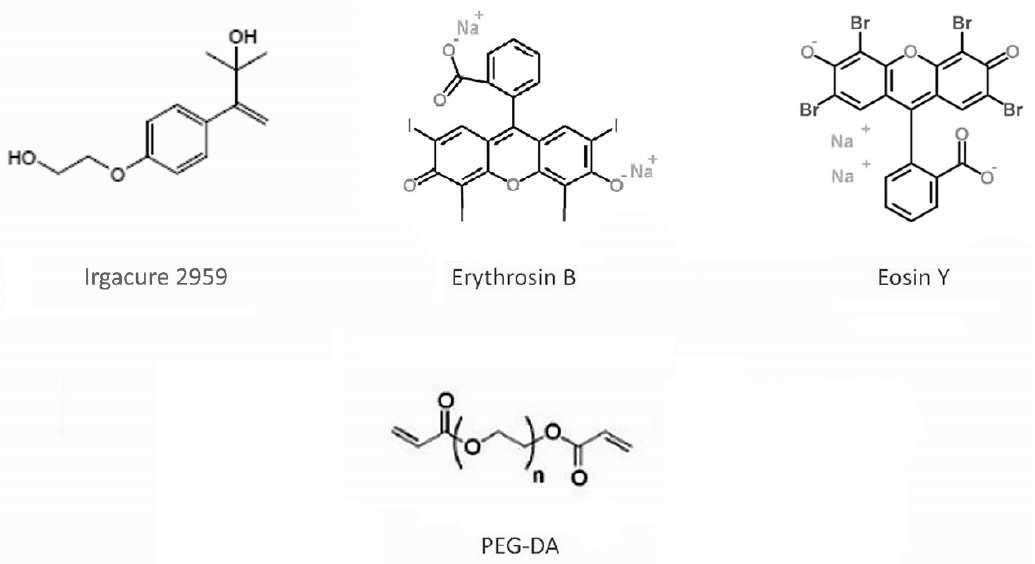
Figure 3. Irgacure 2959, Erythrosin B and Eosin Y are used as photoinitiators (PI); PEG-DA as a precursor for PEG hydrogel.